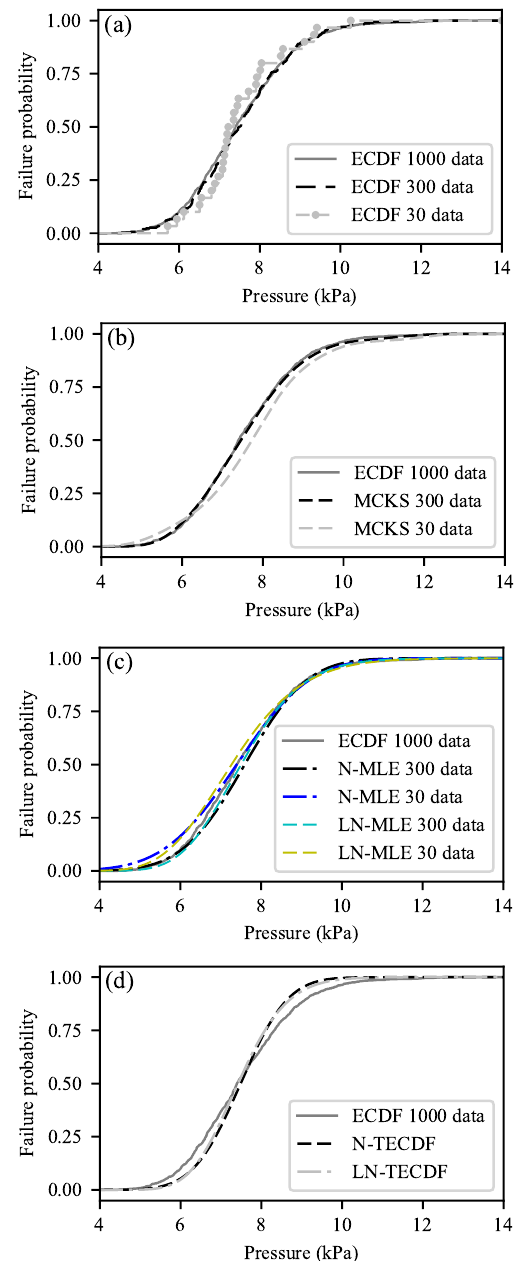
Figure 9. Reliability method comparisons between empirical cumu- lative distribution functions (ECDF) with set ( 1 ,α, a) sample of size 1000 and (a) empirical cumulative distribution functions with sam- ples of sizes 30 and 300; (b) Gaussian kernel smoothing (MCKS) cumulative distributions functions with samples of sizes 30 and 300; (c) maximum likelihood estimation cumulative distribution function (MLECDF) fitting of normal (N-MLE) and log-normal (LN-MLE) distributions with samples of sizes 30 and 300; (d) Taylor expan- sion of the first two centered statistical moments estimates to build normal (N-TE) and log-normal (LN-TE) cumulative distributions